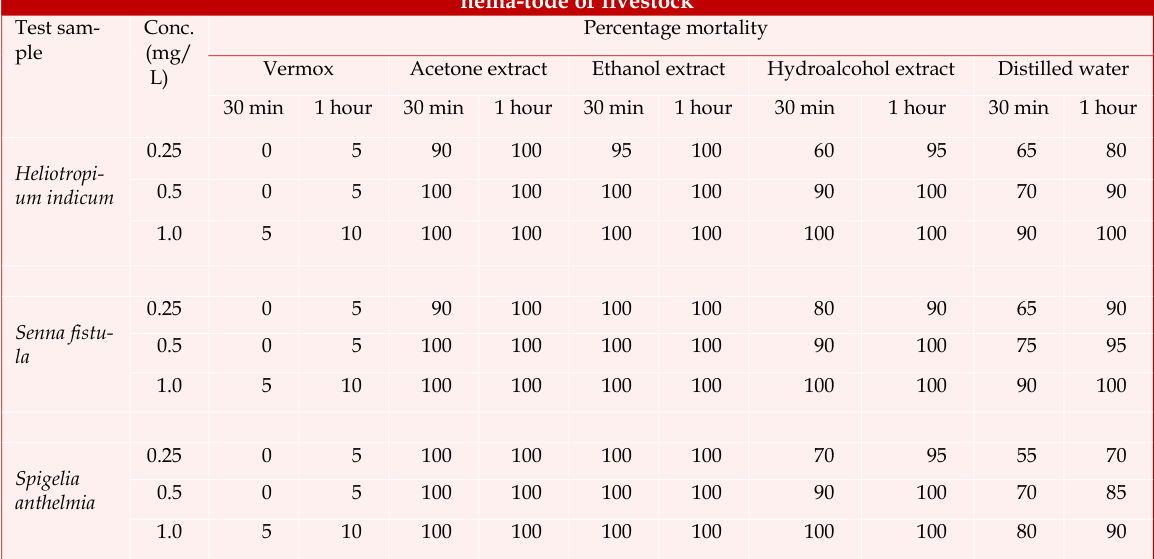
Effect of root extracts of H. indicum, S. fistula and S. anthelmia on larvae mortality of